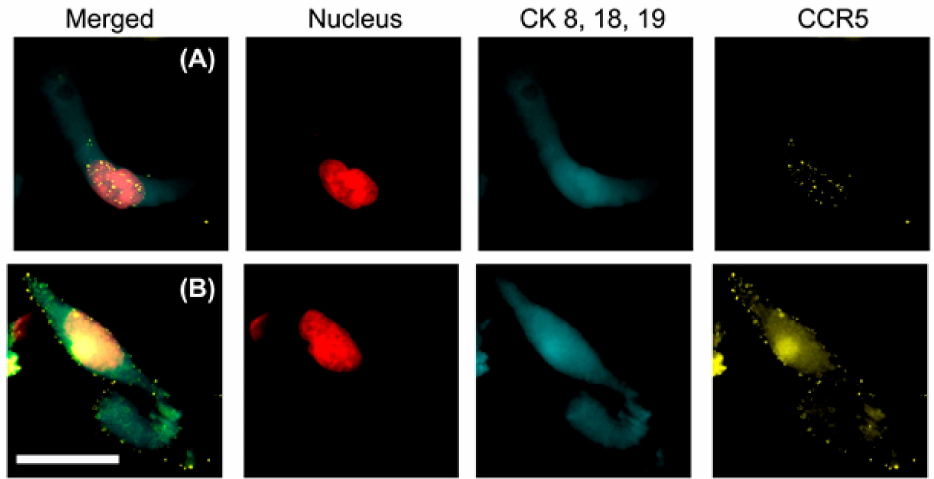
Figure 14. ( A ) CCR5 appears as dots in the cytoplasm of the CAMLs and migrates to the nucleus of the CAML. ( B ) The CCR5 dots then migrate to the surface. The scale bar is 50 µ